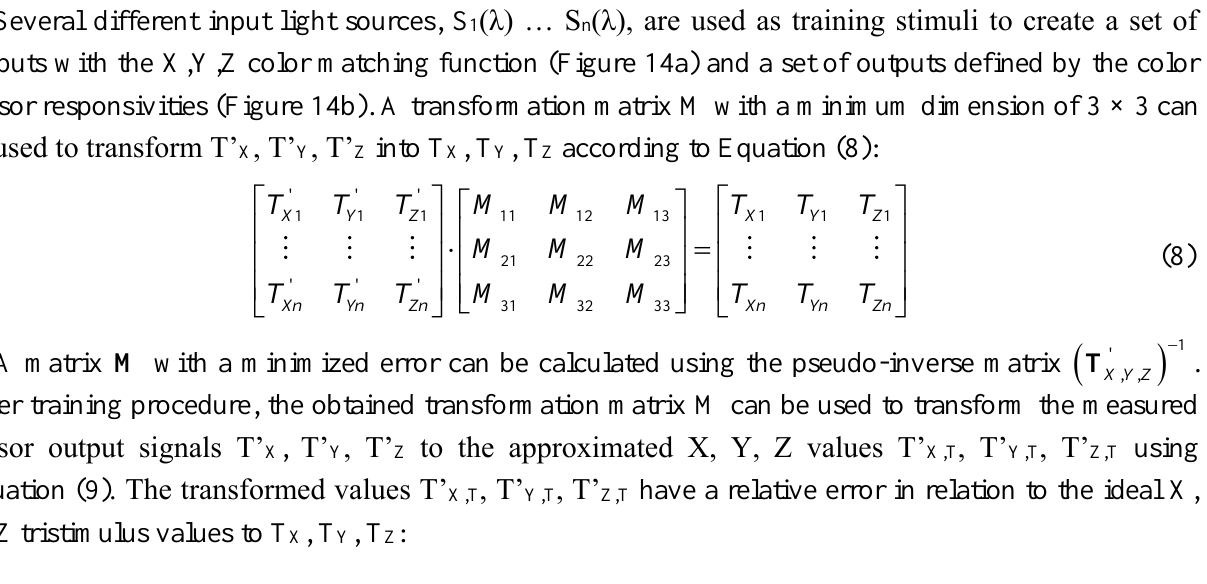
Figure 14. Use of training patterns to generate a transformation matrix suitable for different light